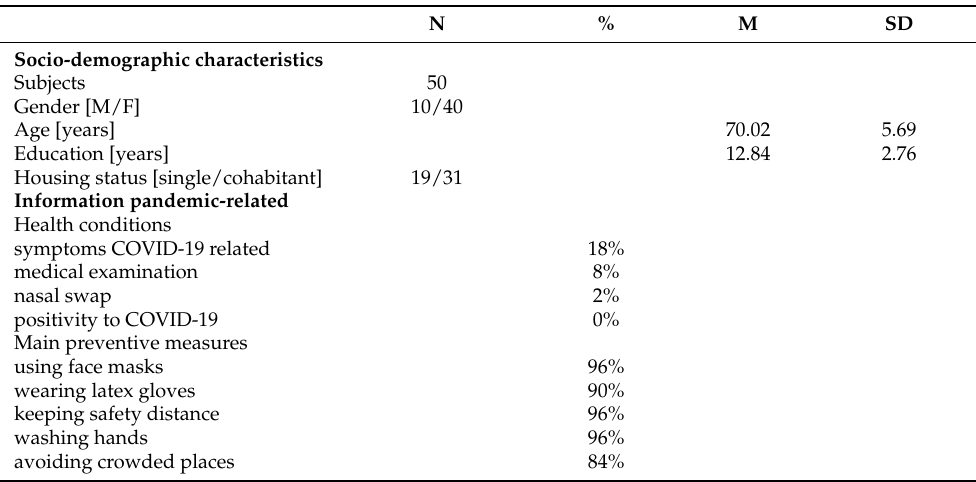
Table 2. Socio-demographic characteristics, pandemic-related information, and changes in habits of the study population at